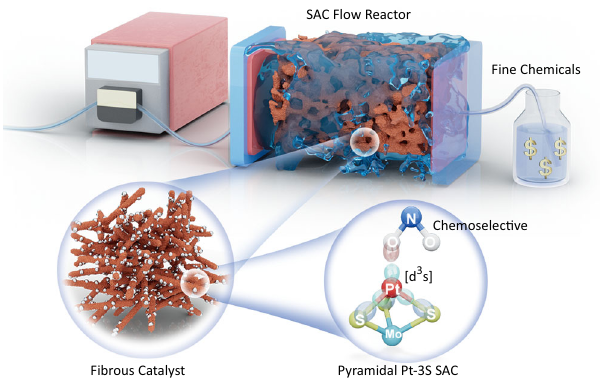
Fig. 1 Schematic illustration. Continuous production of fi ne chemicals is demonstrated by a benchtop, SAC-modi fi ed fl ow